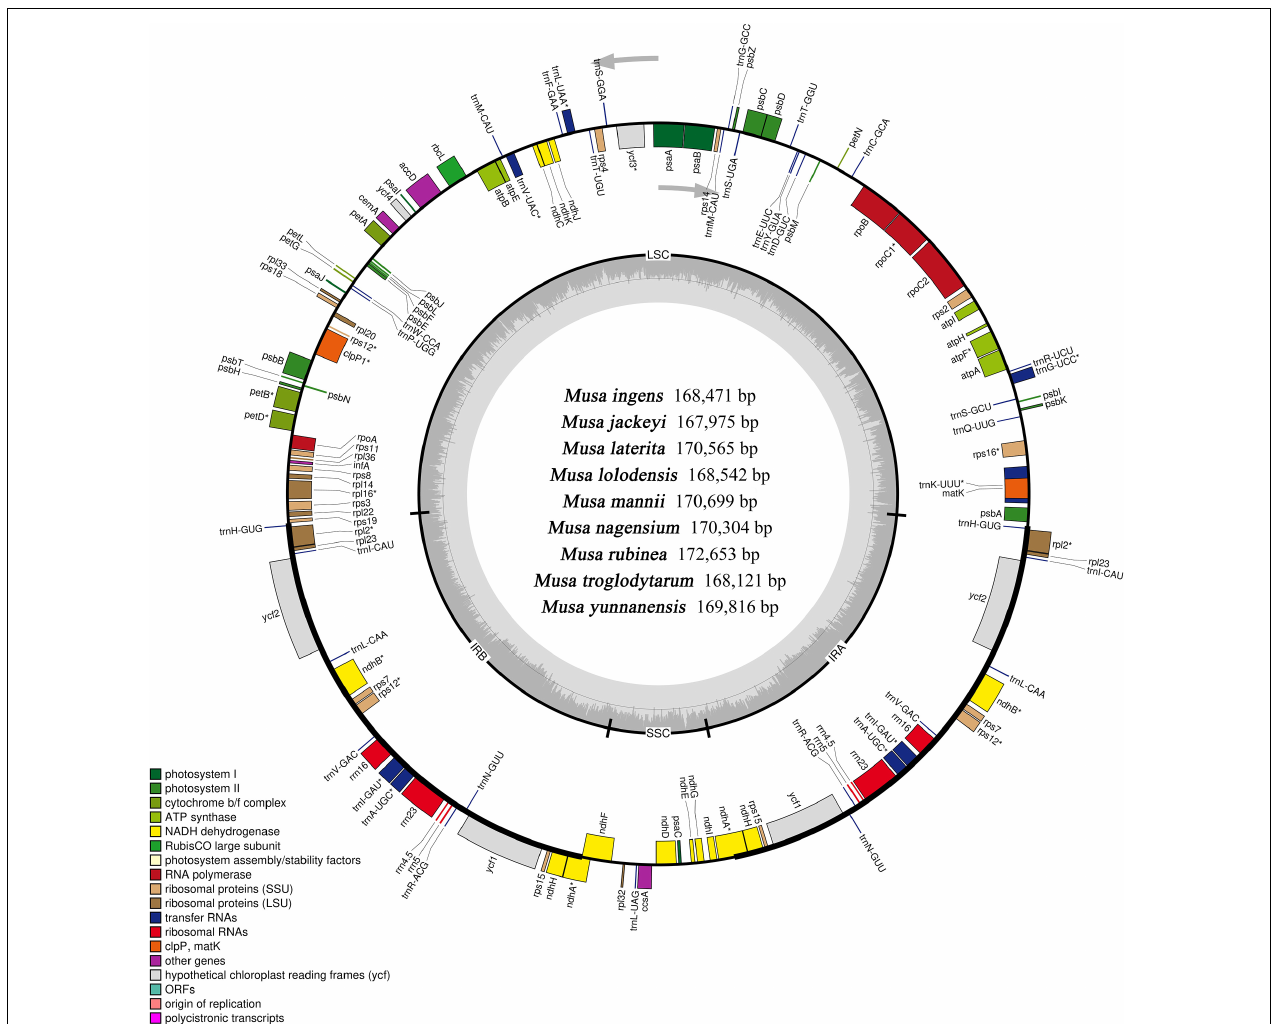
FIGURE 1 | Complete genome map of the chloroplast genome of Musa . The inner gray ring is divided into four areas, Clockwise, and they are: small single-copy region (SSC), inverted repeat sequences B (IRb), large single-copy region (LSC), and inverted repeat sequences A (Ira). The genes in the outer ring region are transcribed clockwise, while those in the inner ring are transcribed counterclockwise. The inner ring dark gray indicates the GC content, the light gray reaction AT content. In the lower left is a legend that classifies chloroplast genes according to their